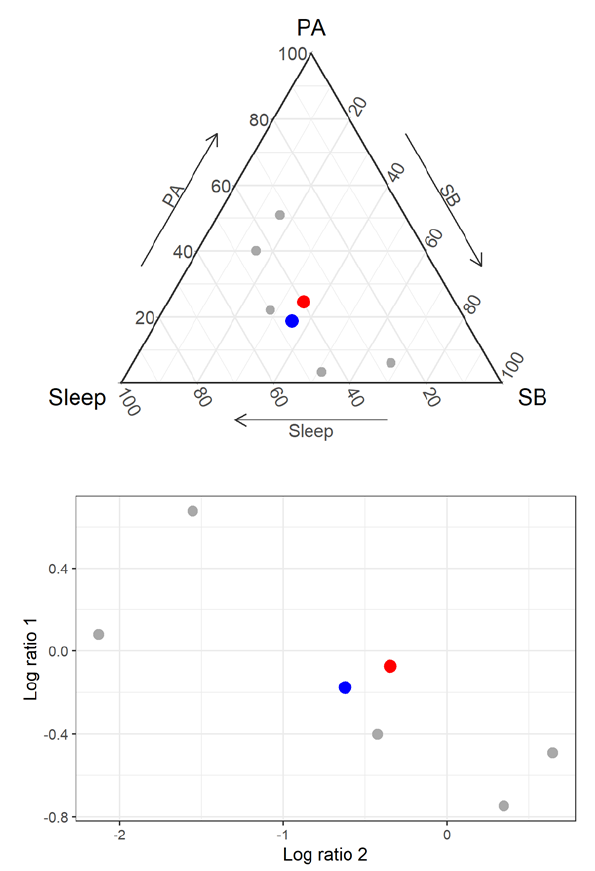
Figure 3. Five randomly selected time-use compositions from the Longitudinal Study of Australian Children (birth cohort, Wave 6). Top panel shows the compositional mean (blue) and arithmetic mean (red) in the ternary diagram. Bottom panel shows real space isometric logratio representation, with their compositional mean (blue) and arithmetic mean (red). PA = physical activity; SB = sedentary behavior.